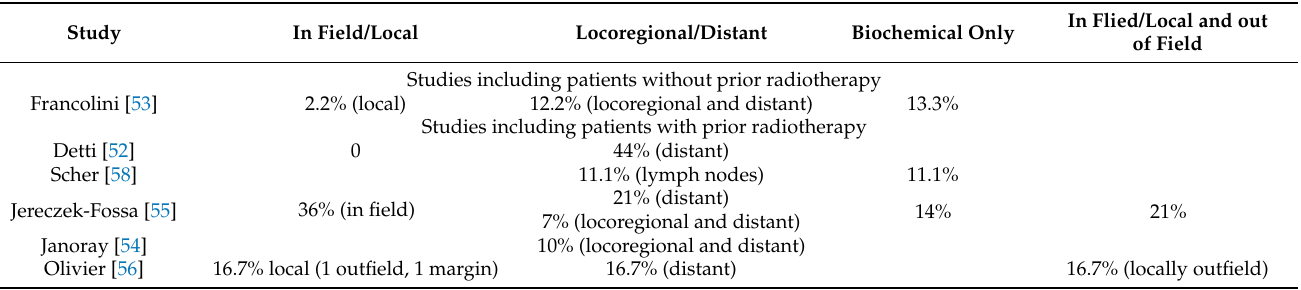
Table 4. Overview of the reported patterns of